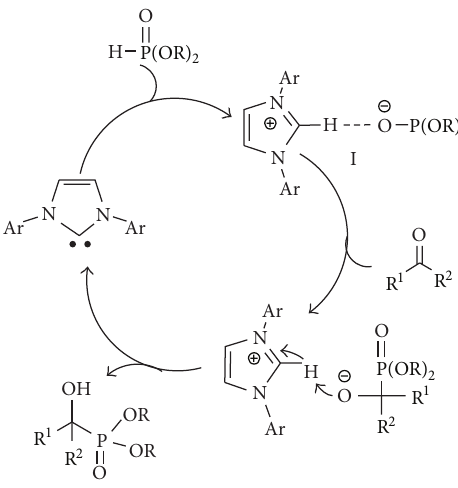
Scheme 1: Proposed reaction